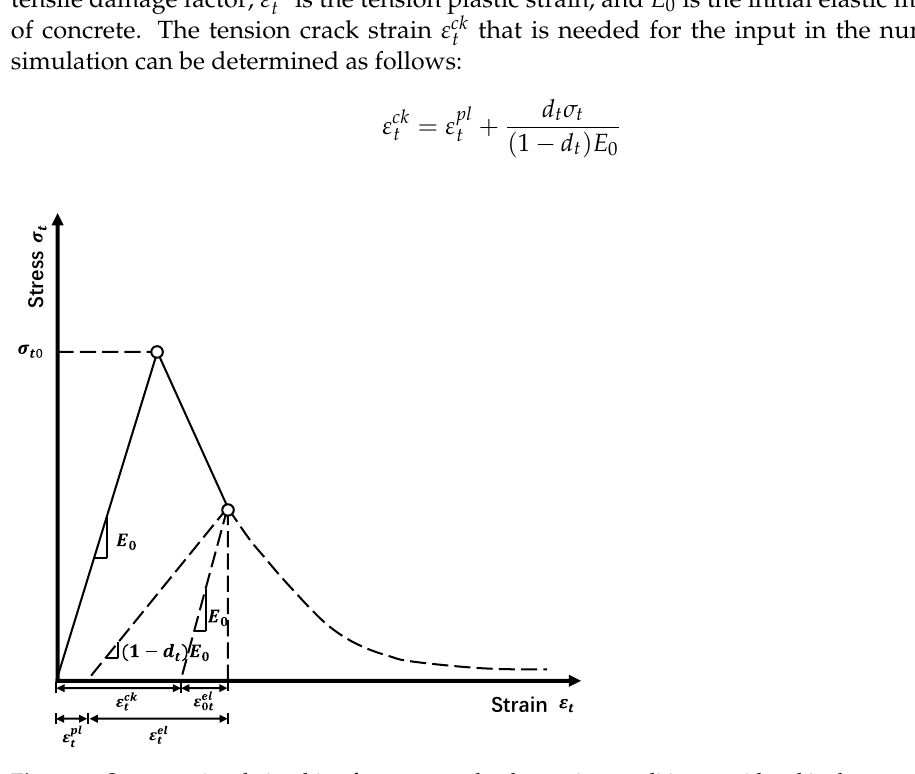
Figure 4. Stress–strain relationship of concrete under the tension condition considered in the present study.